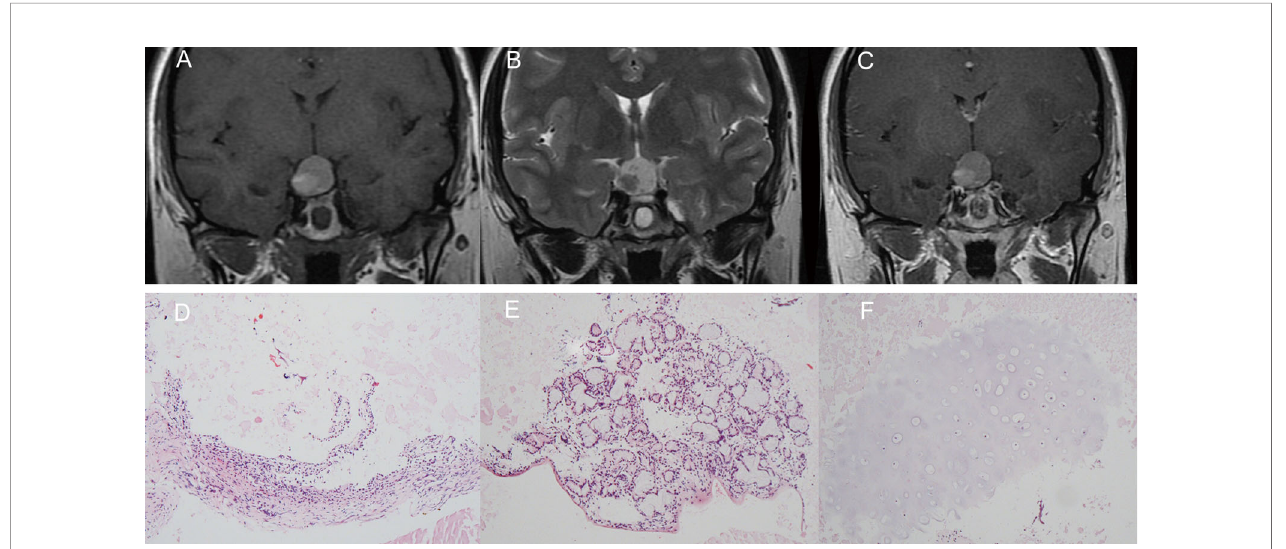
FIGURE 1 | The lesion signal characteristics on magnetic resonance imaging were isointense on T1-weighted imaging and hyperintense on T2-weighted imaging. No obvious gadolinium enhancement was noted (A – C) . Pathological fi ndings: on a background of abundant myxoid stroma, we can see fi brous cyst walls lined with simple cuboidal and short columnar epithelium (H&E ×100, D ), a mass of mucous acinous cells (E) , and some chondroid tissue (F)